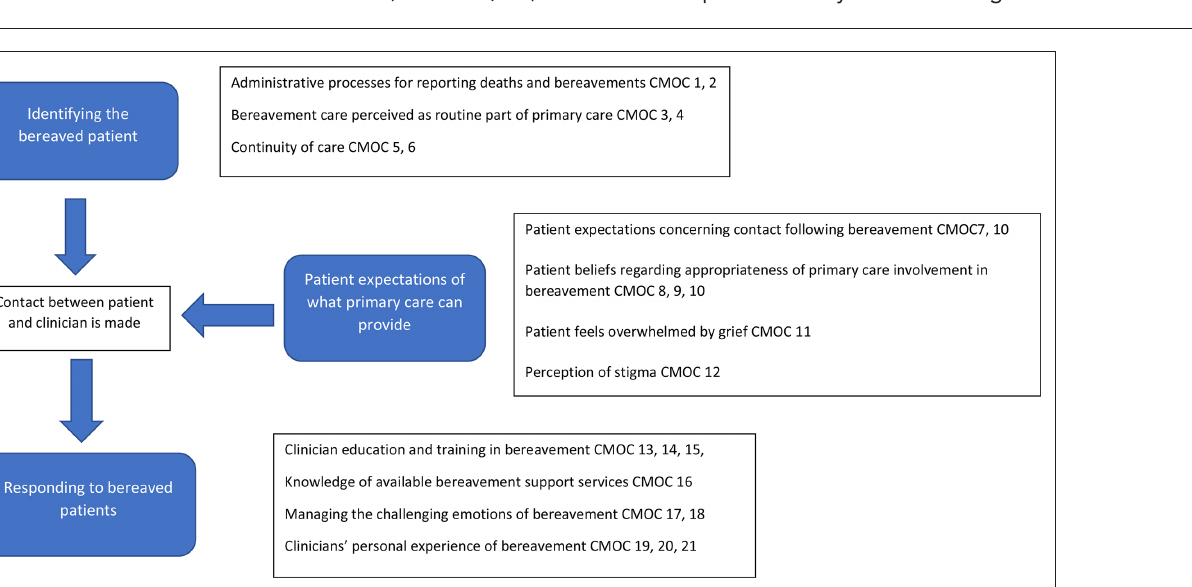
Figure 2 Programme theory of supporting bereavement and complicated grief in primary care. CMOC = context–mechanism–outcome